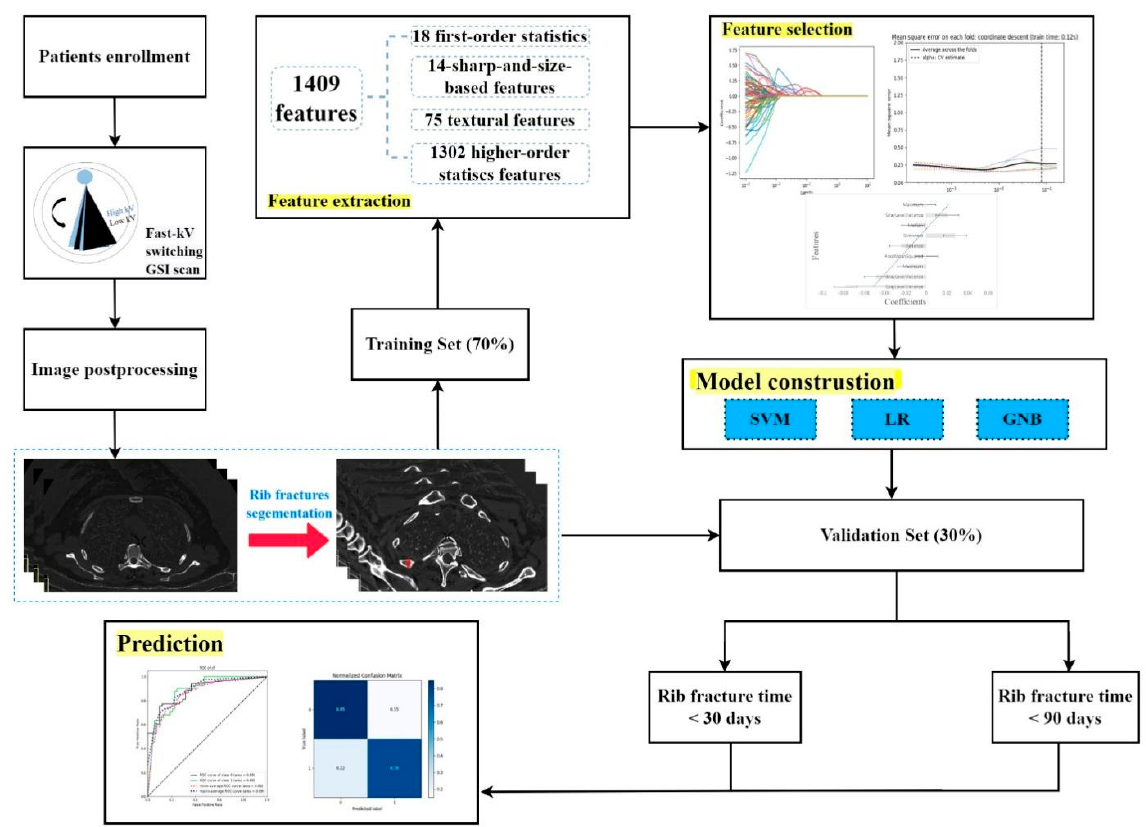
Figure 1. Radiomics workflow.